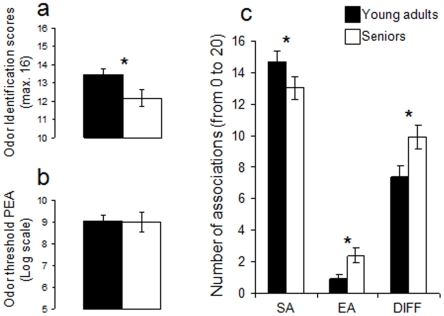
Experiment 1.a) odor identification score in young adults and seniors: seniors had lower scores of odor identification. B) odor thresholds: young adults and seniors did not differ in odor thresholds. c) odor verbalization: Young adults supplied more semantic associations (SA) and fewer emotional associations (EA) and had less difficulty in supplying any associations (DIFF) than seniors. * significant difference at the 5% statistical significance threshold.